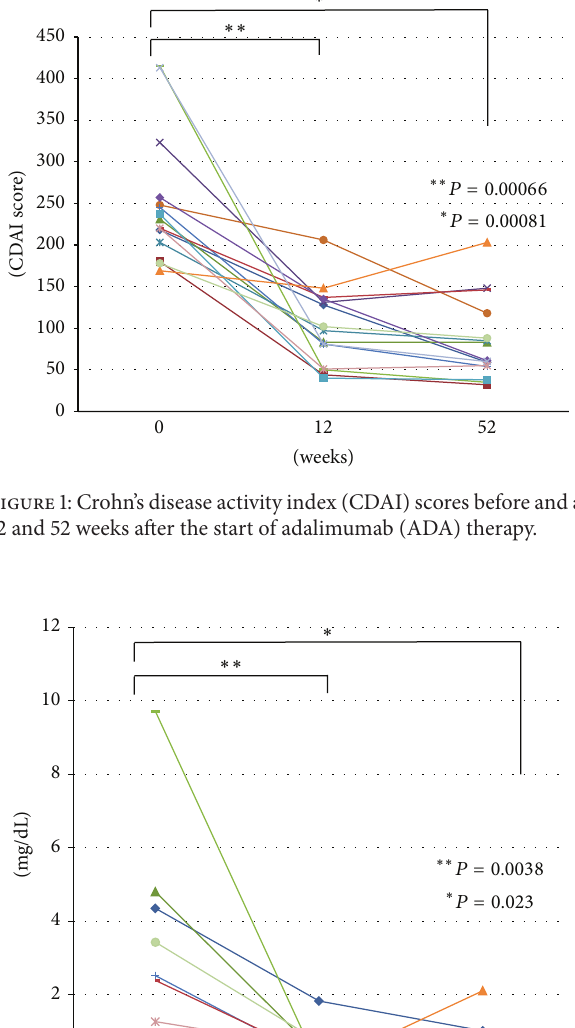
Table 1: Patients’ Baseline Characteristics ( 𝑛 = 15 ).